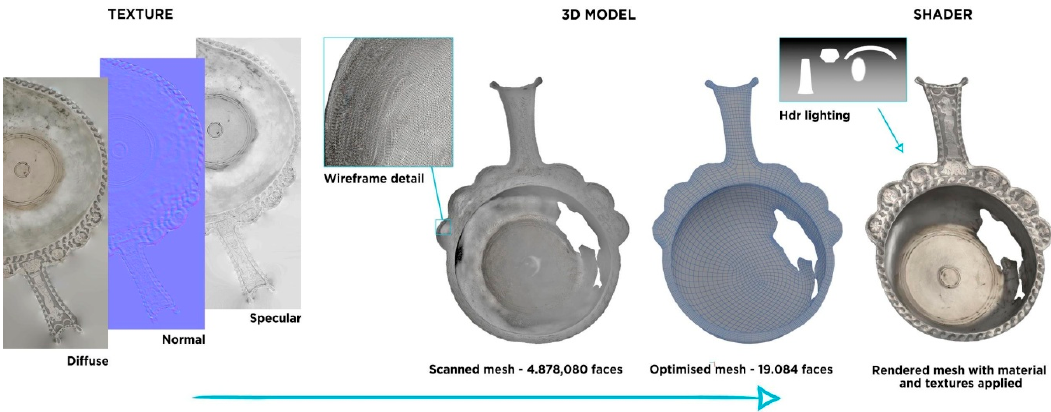
Figure 17. Realistic rendering workflow: the final look of the silver trulla is the result of several elements: texture layers, shading, lighting set-up, and HDRR.